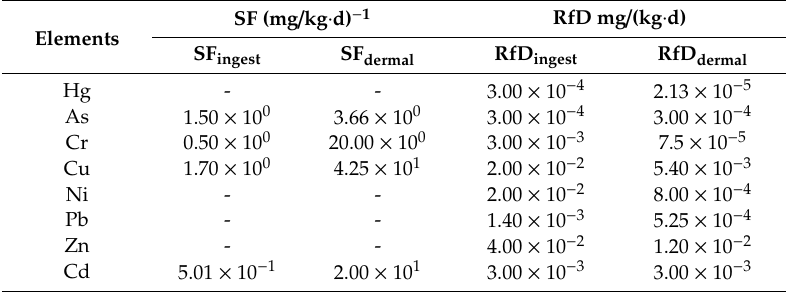
Table 3. Slope factor (SF) for carcinogenic elements and RfD for non-carcinogenic elements.